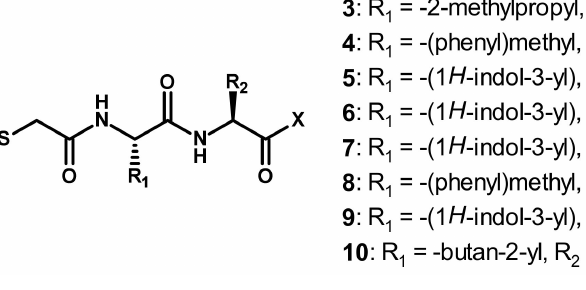
Figure 4. Chemical structures and biochemical activities of the thiols 3 – 10 . K i values were extracted from the original publications [35,37,40].